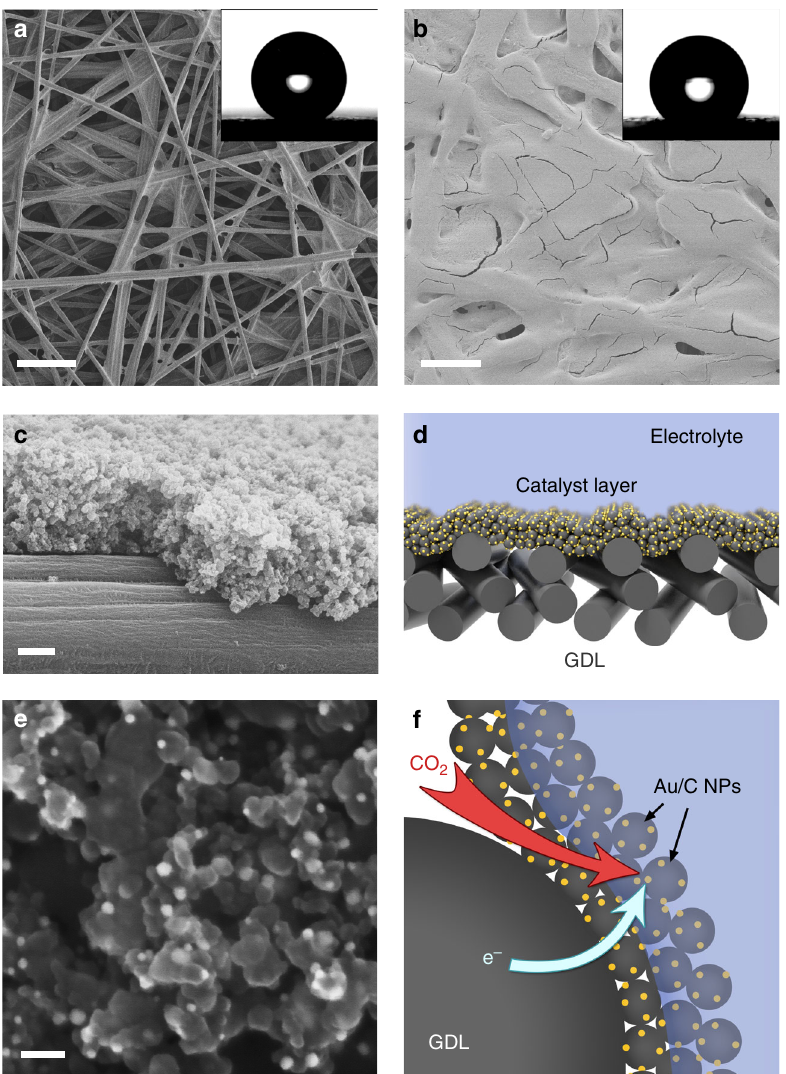
Fig. 1 Structural characterization of the Au/C electrode. a SEM image of a PTFE-modi fi ed carbon fi bre GDL, scale bar: 100 μ m. b SEM image of the electrode after coating with an Au/C NPs fi lm, scale bar: 100 μ m. Insets in ( a – b ) show photographs of water droplets on each electrode. c Cross-sectional SEM image of the Au/C electrode, scale bar: 500 nm. d Schematic illustration of the TPC electrochemical cathode. e SEM image of the Au/C electrode at high magni fi cation, scale bar: 50 nm. f Schematic illustration of the gas – liquid – solid three-phase interfaces of a TPC system for electrochemical CO 2 RR. Source data are provided as a Source data fi